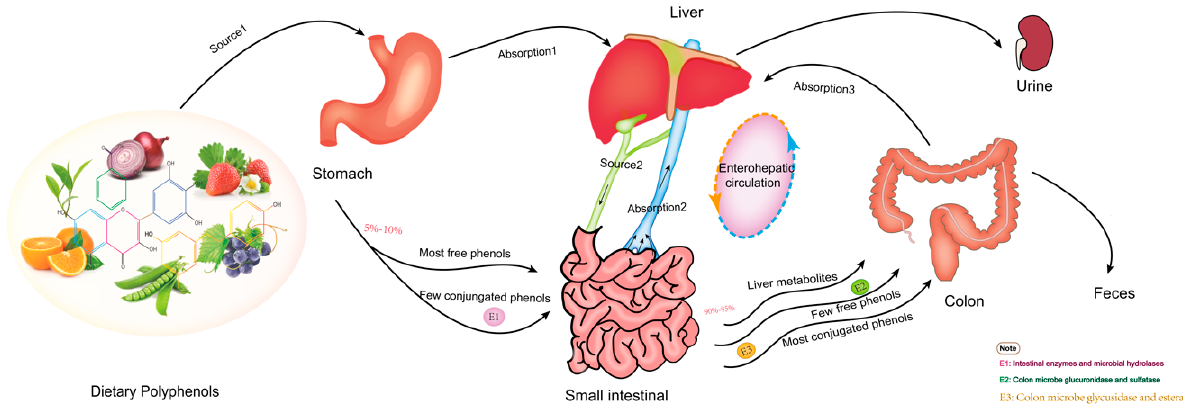
Figure 1. The transformation and absorption of polyphenols in the human